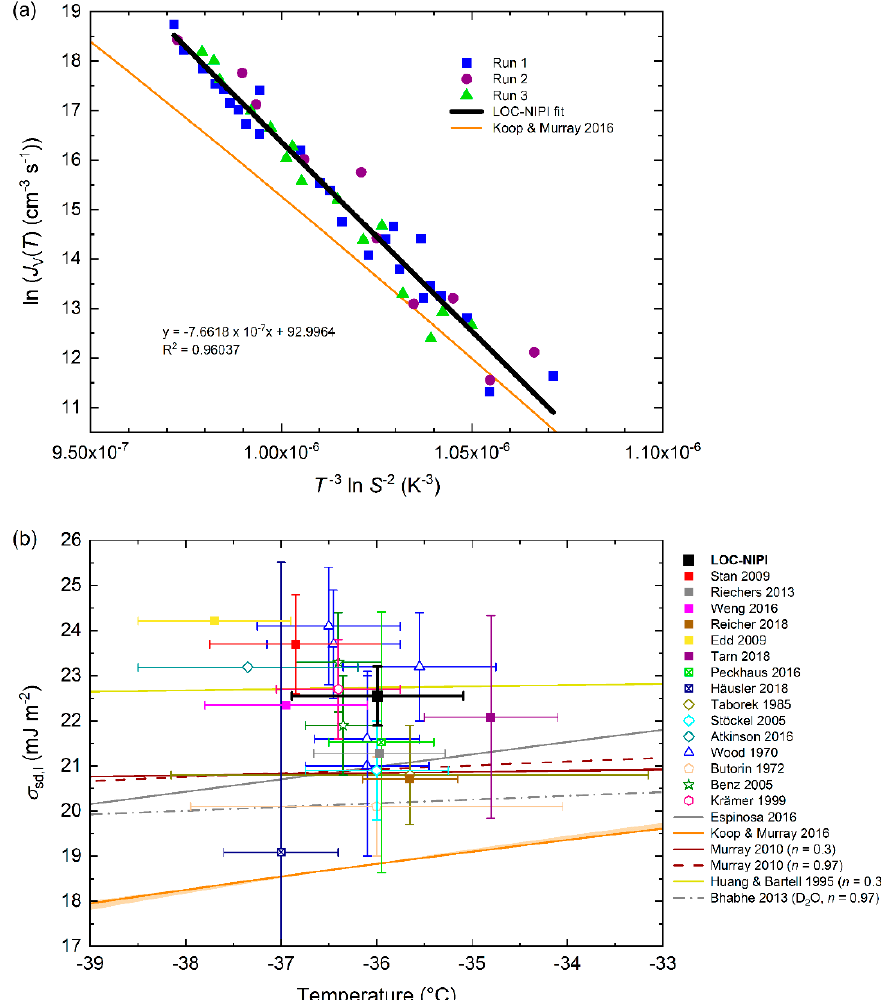
Figure 4. Determination of the interfacial energy of stacking-disordered ice–supercooled water, σ sd,l . ( a ) The LOC-NIPI nucleation rate data as a function of T − 3 (ln S ) − 2 . The slope of the linear fit corresponds to σ sd,l = 22.5 ± 0.7 mJ m − 2 , with an intercept corresponding to A = 2.443 × 10 40 cm − 3 s − 1 . The parameterisation of Koop and Murray is shown for comparison [41]; ( b ) comparison of the LOC-NIPI derived interfacial energy to those determined from other microfluidic instruments (shown as solid squares) [26–29,32,37], including those calculated from digitised data (shown as squares with crosses inside) [31,33]. In addition, parameterisations available in the literature (shown as lines) [14,23,41,49,63,70–72], a value calculated here from Atkinson et al. [7], and literature values [7,51,59–62,69] (shown as various symbols) obtained from Murray et al. [49] are presented. Symbols represent the midpoint of the temperature range explored in each case, while the error bars represent the full temperature range that the σ sd,l data covered. Parameterisations of Murray et al. [49], Huang and Bartell [23], and Bhabhe et al. [70] based on a temperature dependency of σ sd,l were determined using the equation σ sd,l = σ sd,l ( T 0 ) × ( T / T 0 ) n [23], where T is temperature and σ sd,l ( T 0 ) is a reference interfacial energy at reference temperature T 0 . Values of σ sd,l ( T 0 ), T 0 , and n (provided in the legend) were obtained from the relevant publications.